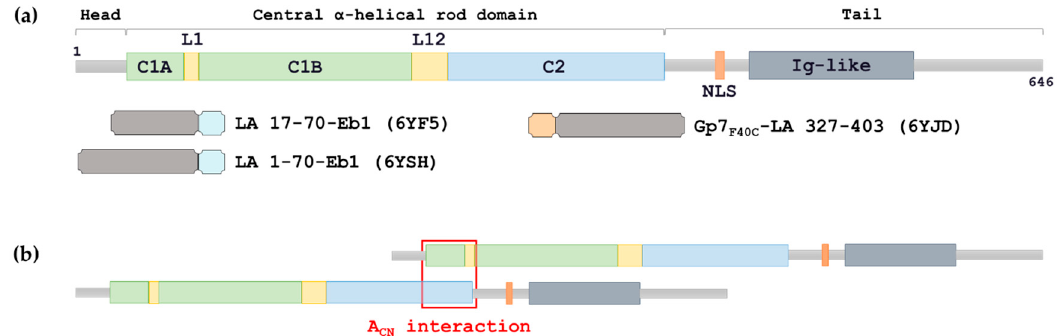
Figure 1. ( a ) Schematic representation of the primary structure of lamin A. C1A, coil1A; L1, linker 1; C1B, coil1B; L12, linker 2; C2, coil2; NLS, nuclear localization signal; Ig-like, immunoglobulin-like domain. Chimeric fragments used here for crystallographic studies are shown below. The capping motifs Eb1 and Gp7 F40C are coloured cyan and wheat, respectively. ( b ) Scheme of longitudinal lamin assembly which is based on the A CN interaction.